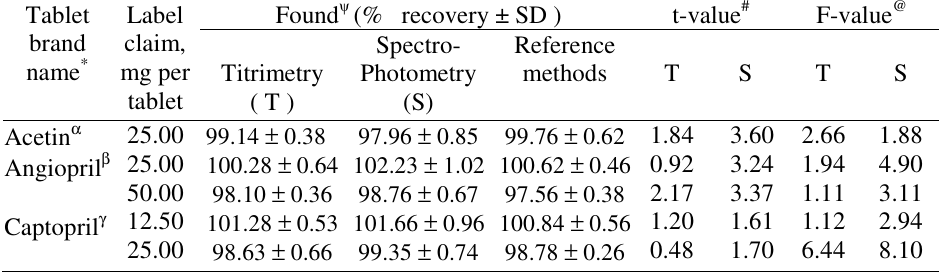
Table 2. Results of analysis of tablets using the proposed methods